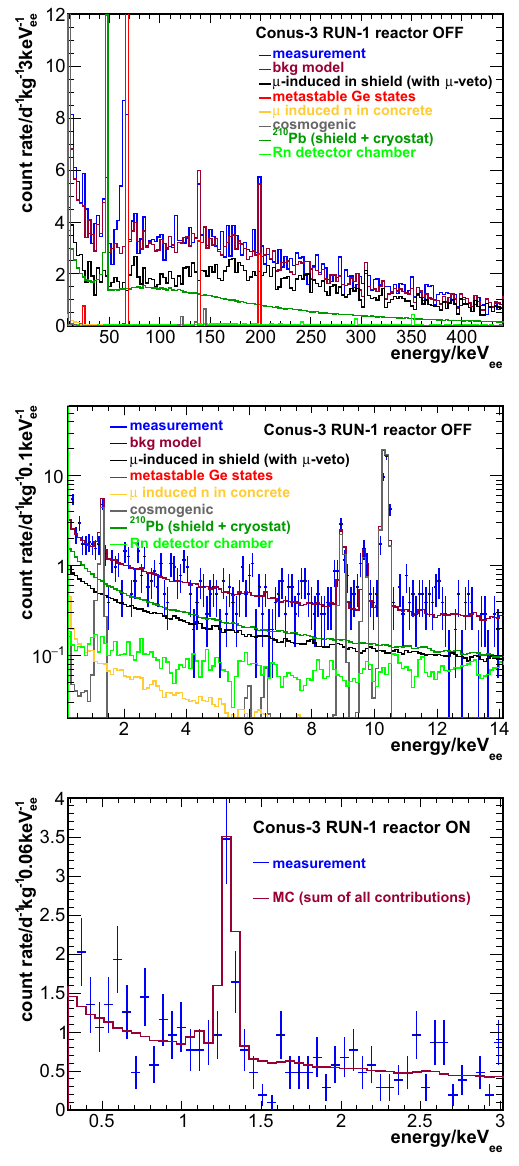
Fig. 21 ThemeasuredbackgroundspectrumofC3isdepictedtogether with the background model in the highE range and lowE range and an even smaller energy range focusing on the ROI for CE ν NS. The MC spectra from the various background sources are shown in differ- ent colors. The strong increase within the lowE range below 400eV ee is attributed to noise and is fitted with an exponential two-parameter model. For the highE range, reactor ON data were used, for which the Rn background was completely suppressed